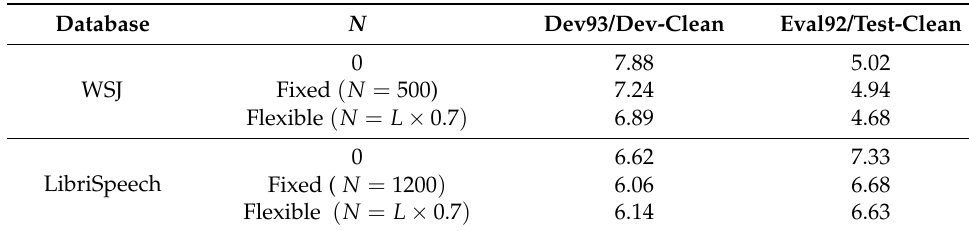
Table 5. WER (%) results according to the maximum augmentation range. For the flexible N case, the ratio was 0.7 and the frame rate range was 0.5–1.5 in the proposed method.